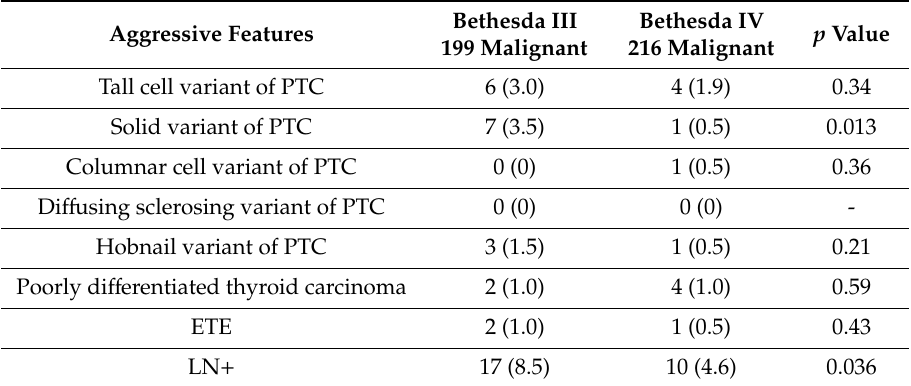
Table 2. Aggressive features by Bethesda category.